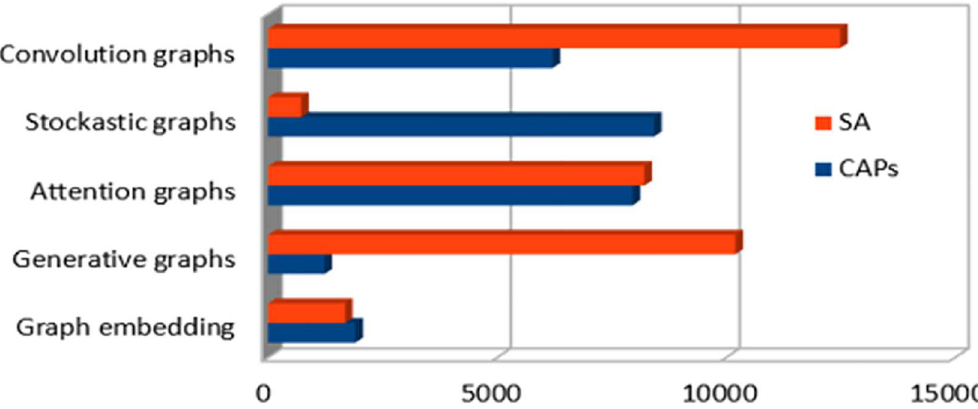
Fig 9. Similar research addressing “SA” and “CAPs” relative to graph technologies between 2000–2021 (based on the previous analysis (Fig 7), graphs have been getting more attention by year 2000).